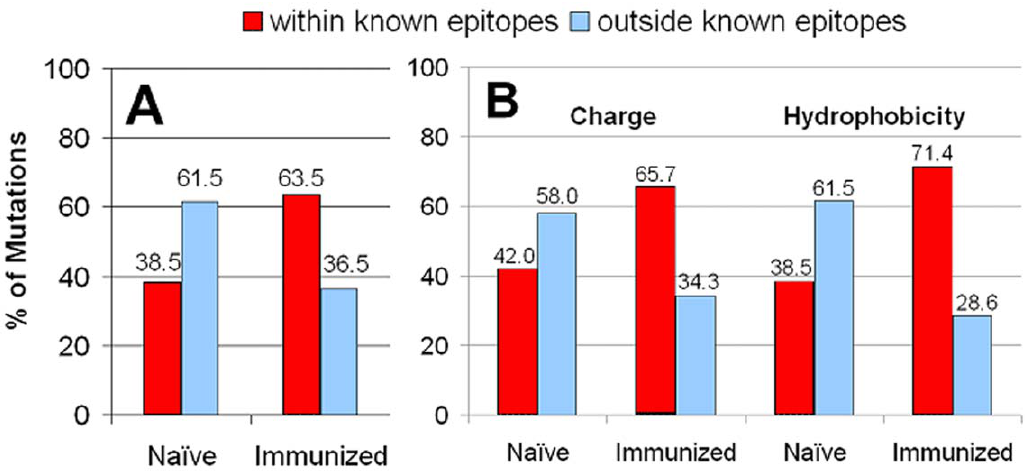
Figure 5. Relationships between frequency of HA mutations, epitopes, and charged or hydrophobic amino acids. Bars show frequency of mutations at each amino acid observed in variants isolated from nasal washes of influenza virus infected Guinea pigs. Frequency calculated by dividing number of mutations at a given residue with the total number of variants observed. Panel A: variants from naı¨ve Guinea pigs, Panel B: variants from HA-immunized animals.